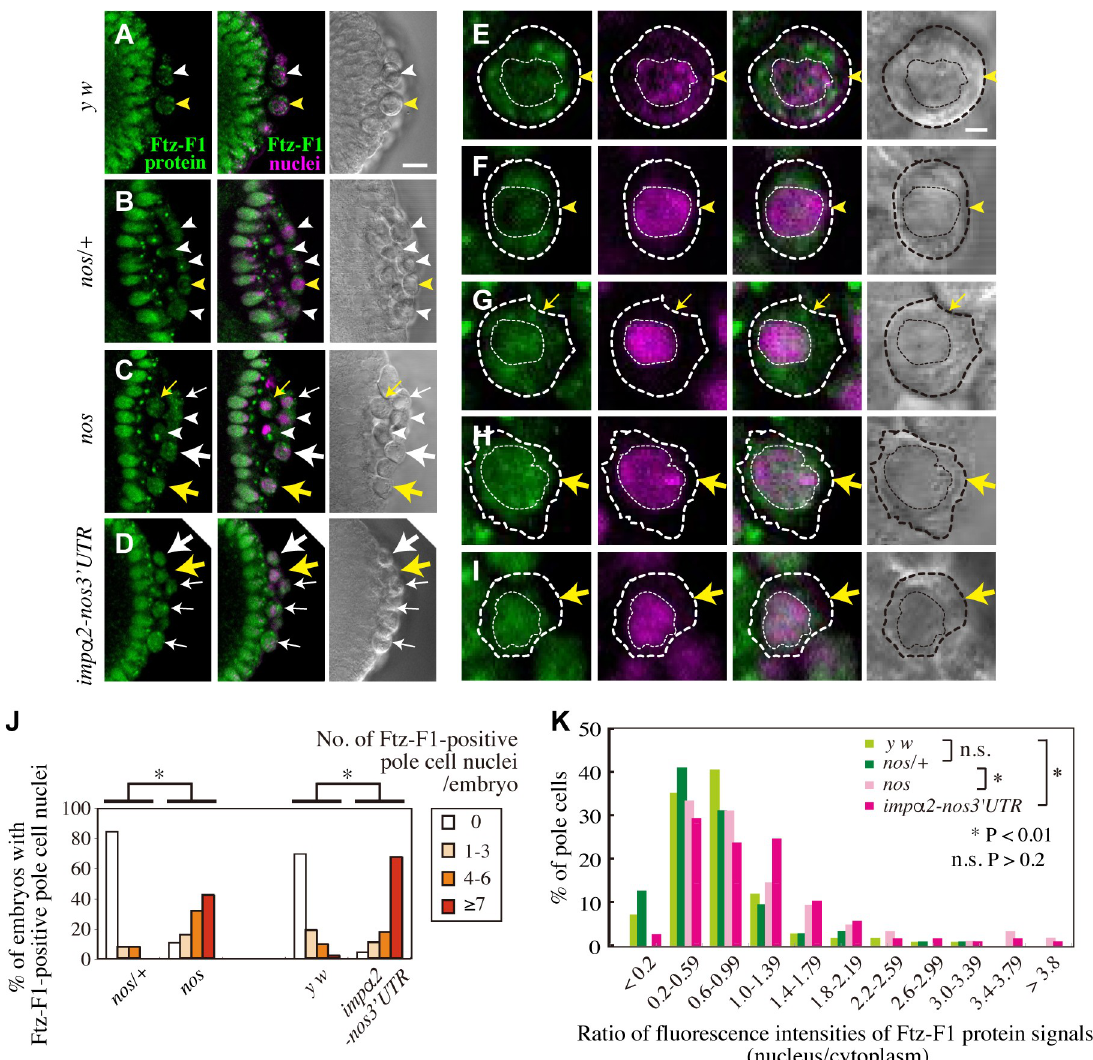
Fig 3. Nos represses nuclear import of Ftz-F1 in pole cells by inhibiting Imp α 2 production. ( A–D ) Ftz-F1 distribution in pole cells of embryos derived from y w ( A ), nos /+ ( B ), nos ( C ), and imp α 2-nos3´UTR ( D ) females mated with y w males. Stage-5 embryos were double-stained for Ftz-F1 (green) and nuclei (propidium iodide: magenta). DIC images (right) are also shown. Large arrows and arrowheads point to pole cells with Ftz-F1 signal enriched in the nucleus and cytoplasm, respectively. Small arrows point to pole cells with Ftz-F1 signal evenly distributed in the nucleus and cytoplasm. Note that Ftz-F1 is enriched in somatic nuclei. ( E–I ) Magnified images of pole cells double-stained for Ftz-F1 (green) and propidium iodide (magenta). Pole cells shown by yellow arrowheads in A ( E ) and B ( F ), small and large yellow arrows in C ( G and H ), and large yellow arrow in D ( I ) are shown. DIC images (right) are also shown. Dashed thick and thin lines outline pole cells and their nuclei, respectively. Scale bars, 10 μ m ( A ) and 2 μ m ( E ). ( J ) Expression of Ftz-F1 was examined in pole cell nuclei of embryos from late stage 4 to stage 6. Embryos were derived from nos/+ , nos , y w , and imp α 2-nos3´UTR females mated with y w males. Percentages of embryos containing 0 (white), 1–3 (pale orange), 4–6 (orange), or � 7 (red) pole cells with enrichment of Ftz-F1 signal in the nucleus are shown. For each genotype, 19–57 embryos were observed. Significance was calculated using Fisher’s exact test ( � : P < 0.01). ( K ) Nuclear import of Ftz-F1 in pole cells of embryos derived from y w (lime green), nos/+ (green), nos (pink), and imp α 2-nos3´UTR females (pinkish-purple), mated with y w males. Embryos from late stage 4 to stage 5 were double- stained with anti-Ftz-F1 antibody and DAPI or propidium iodide. Fluorescence intensities of Ftz-F1 signal in the nuclear and cytoplasmic areas of individual pole cells were measured on each section of serial confocal images, and the ratio of fluorescence intensities (nucleus/cytoplasm) was calculated (see Materials and Methods). Percentages of pole cells with each fluorescence intensity ratio are shown. For each genotype, 133–299 pole cells were counted. Significances were calculated using chi-square